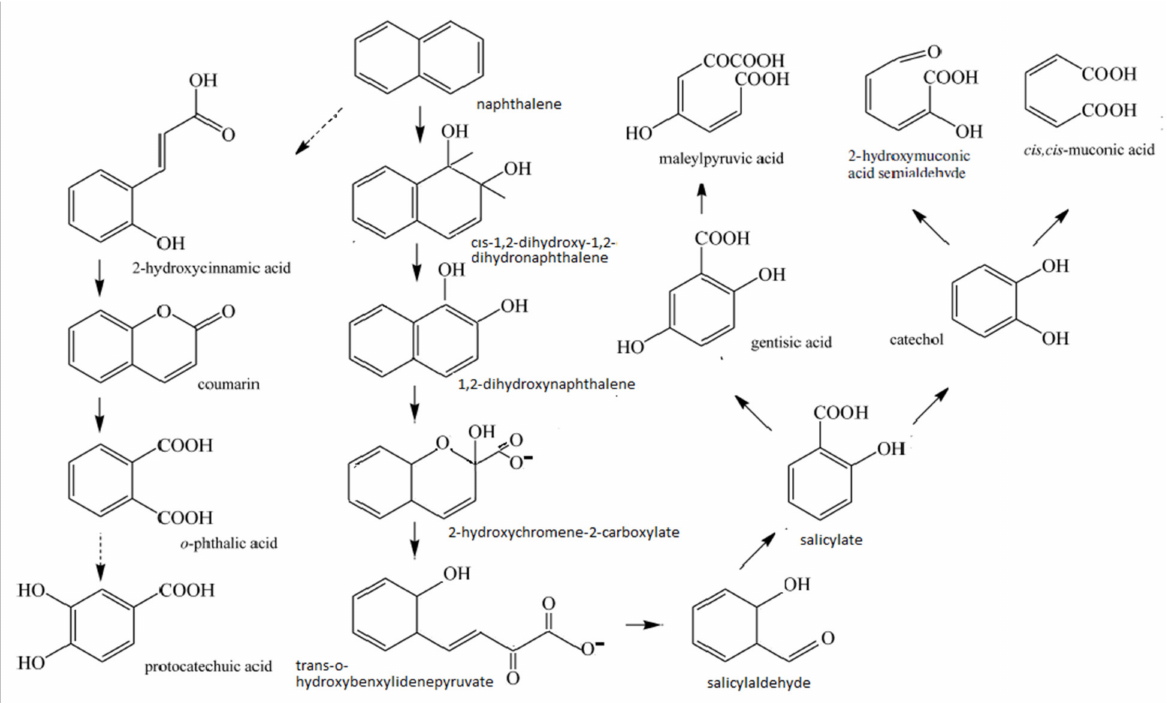
Figure 1. Possible pathways of the bacterial degradation of